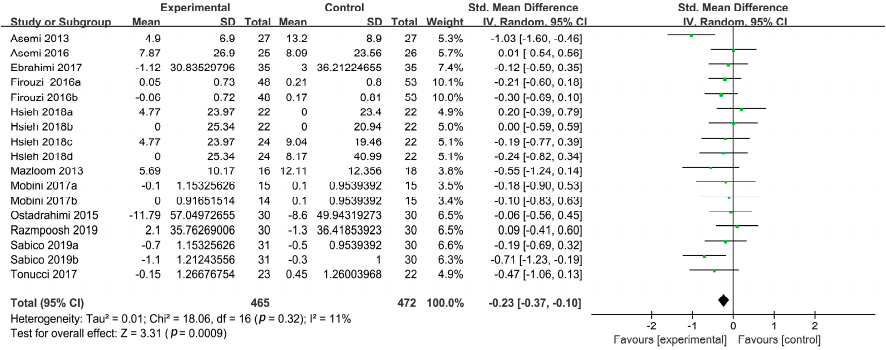
Figure 3. Forest plot of the effects of probiotics on TC concentrations.